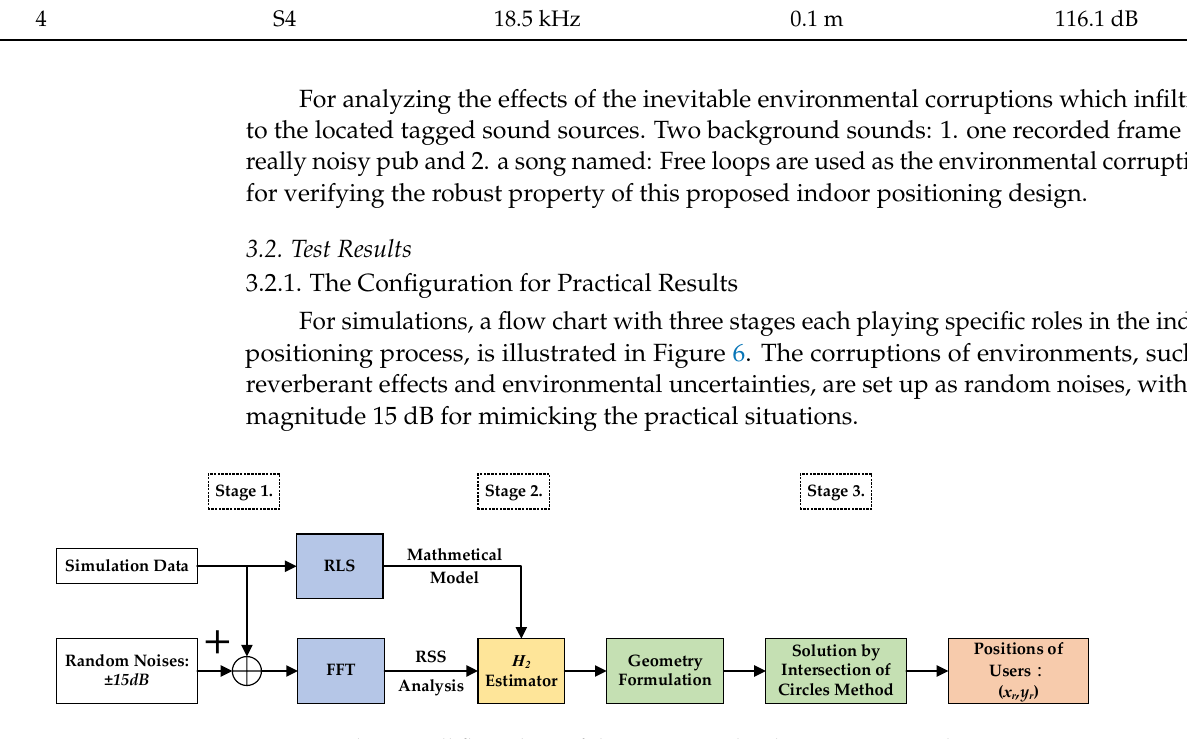
Figure 6. The overall flow chart of these proposed indoor positioning designs.